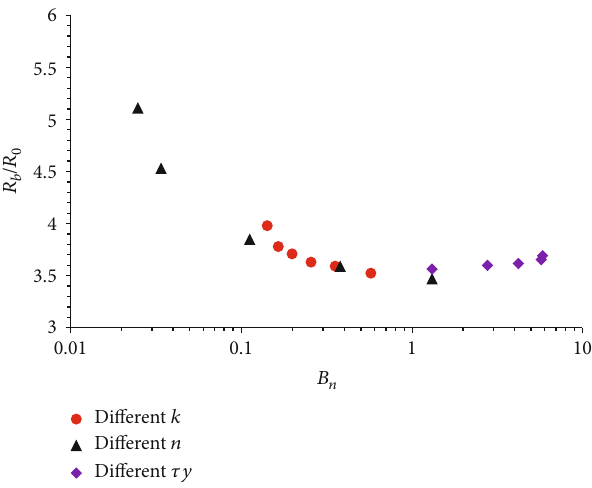
Figure 12: Variation of dimensionless equivalent radius of detached value. bubble with the Y g